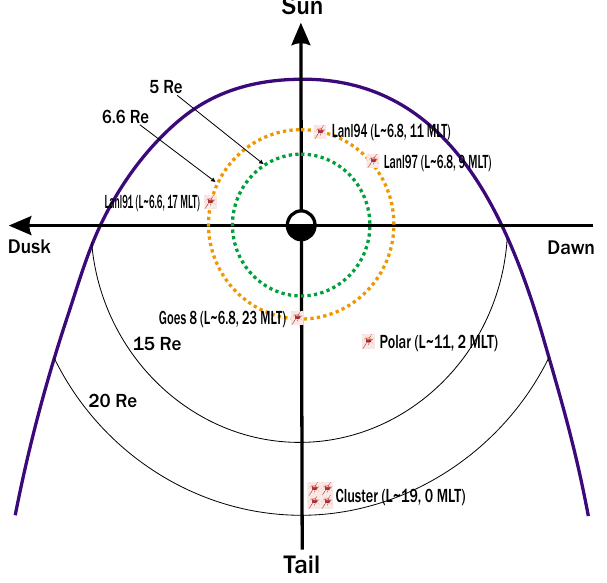
Fig. 1. The average spatial positions of all spacecraft used in this study for the time interval 04:00-04:30 UT.